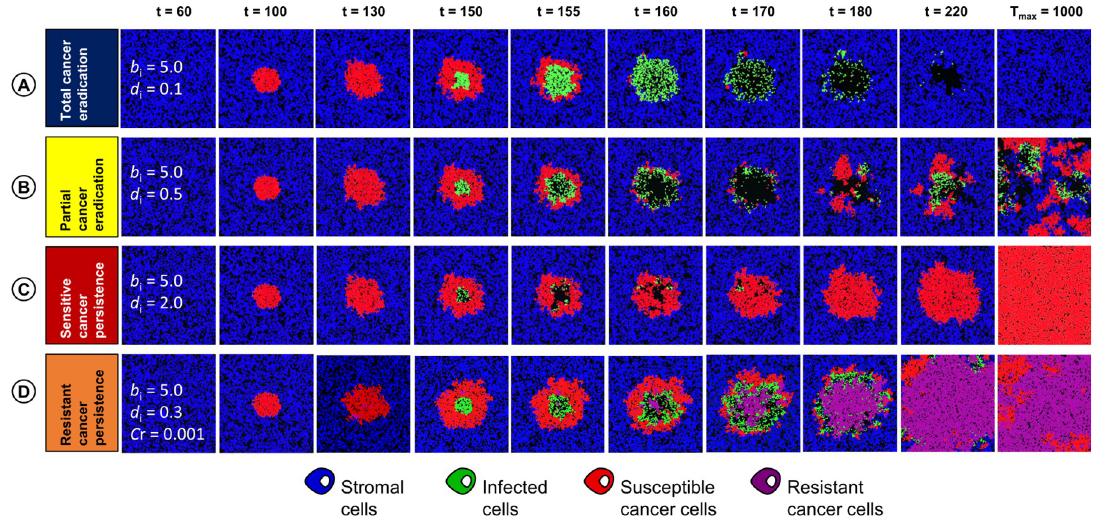
Fig 2. Visualization of different outcomes of oncolytic virotherapy. In our model, virus infection in the tumour tissue can result in four therapeutic outcomes: (A) total cancer eradication; (B) partial cancer eradication; (C) persistence of a virus-sensitive cancer; and (D) persistence of a partially virus-resistant cancer. The snapshot ( t = 60) indicates the parameter values in regard to which the four simulations differ from each other: the rate of viral spread ( b i ), the death rate of infected cells ( d i ), and the probability that the daughter cell of a sensitive cancer cell becomes resistant